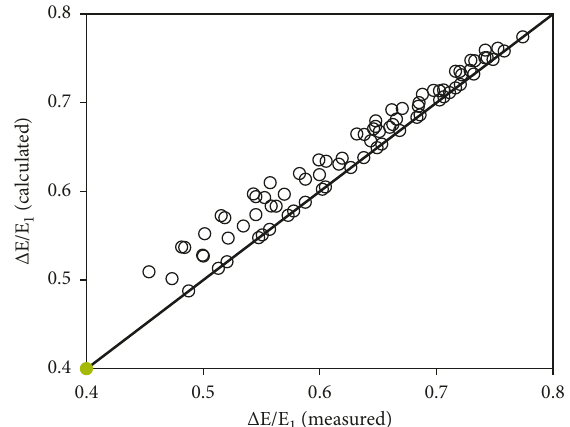
Figure 9: Measured and computed values Δ H / H